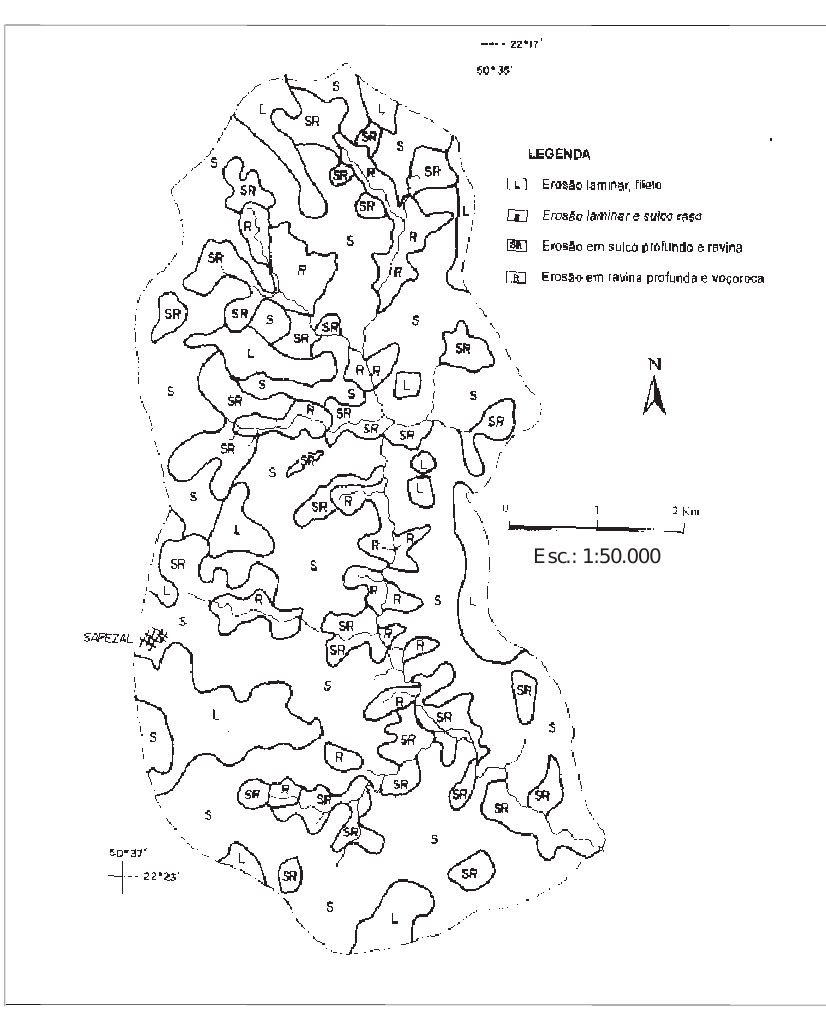
Figura 4. Classes de distribuição espacial das erosões lineares e laminares na microbacia do ribeirão Água da Cachoeira